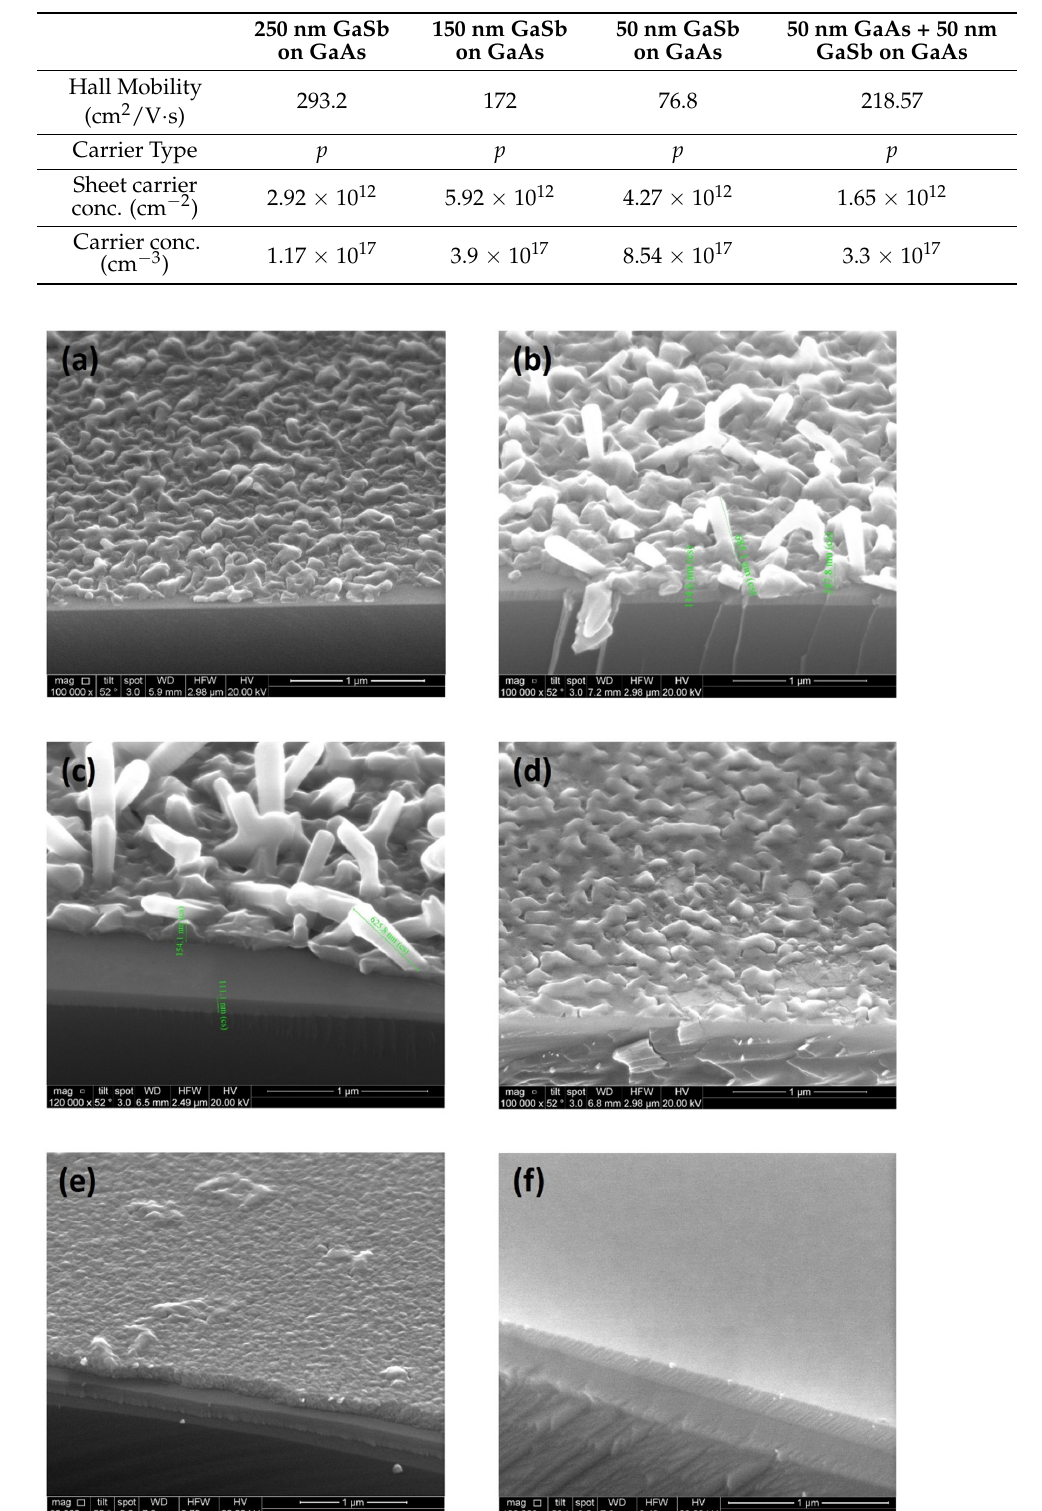
Table 2. Room temperature Hall effect measurement results for poly-GaSb films grown on GaAs at